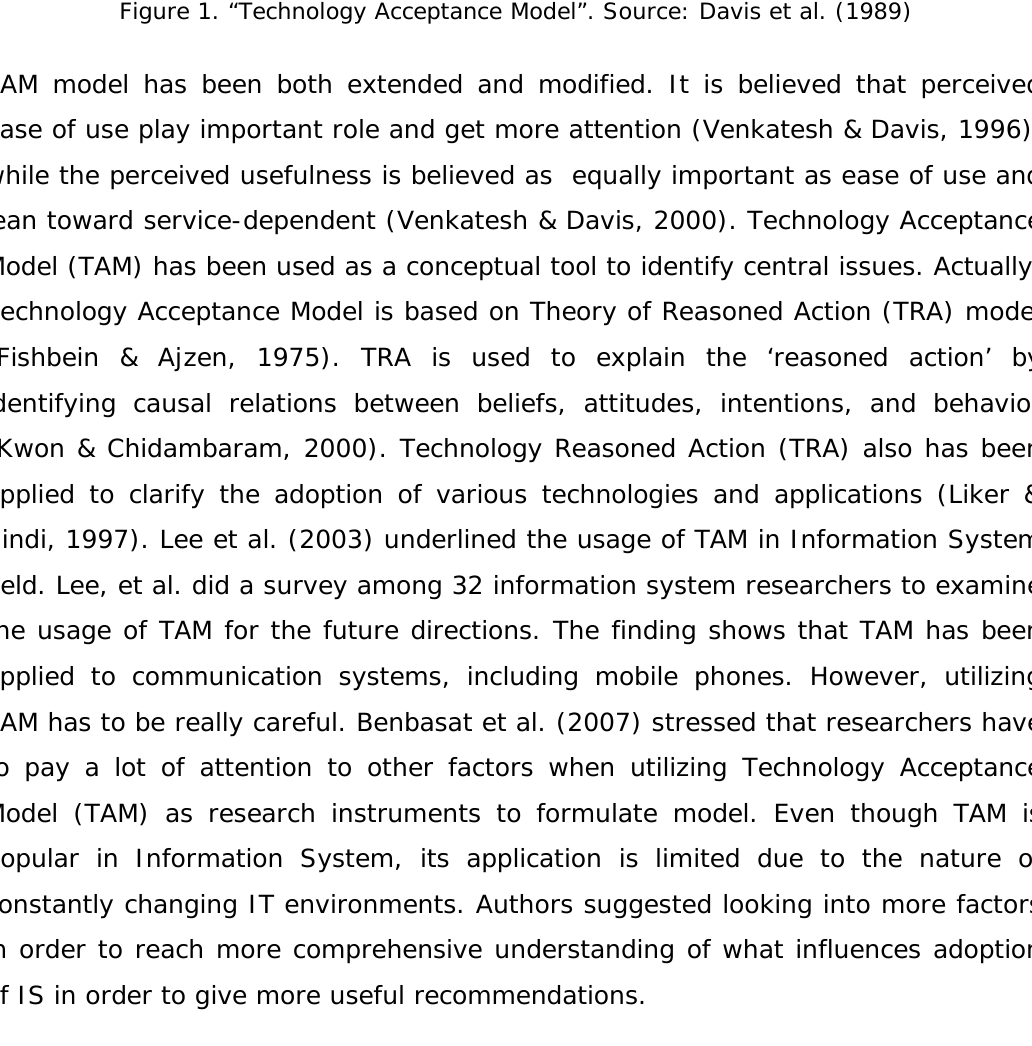
Figure 1. “Technology Acceptance Model”. Source: Davis et al.